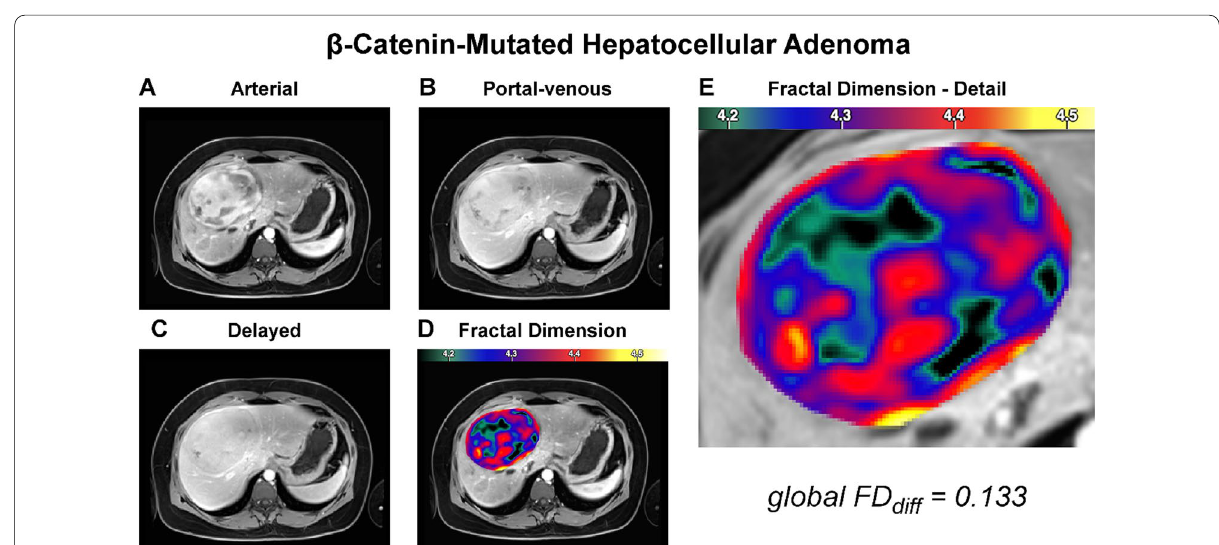
Fig. 3 Representative case of β-catenin-exon-3-mutated hepatocellular adenoma. The panel organization is the same throughout Figs. 2, 3, 4, and 5. The depicted patient was a 34-year-old female with a 9-cm painful mass in the right liver lobe, showing arterial phase hyperenhancement without clear washout. Subsequent biopsy established the diagnosis of β-catenin-exon-3-mutated adenoma. The lesion was surgically